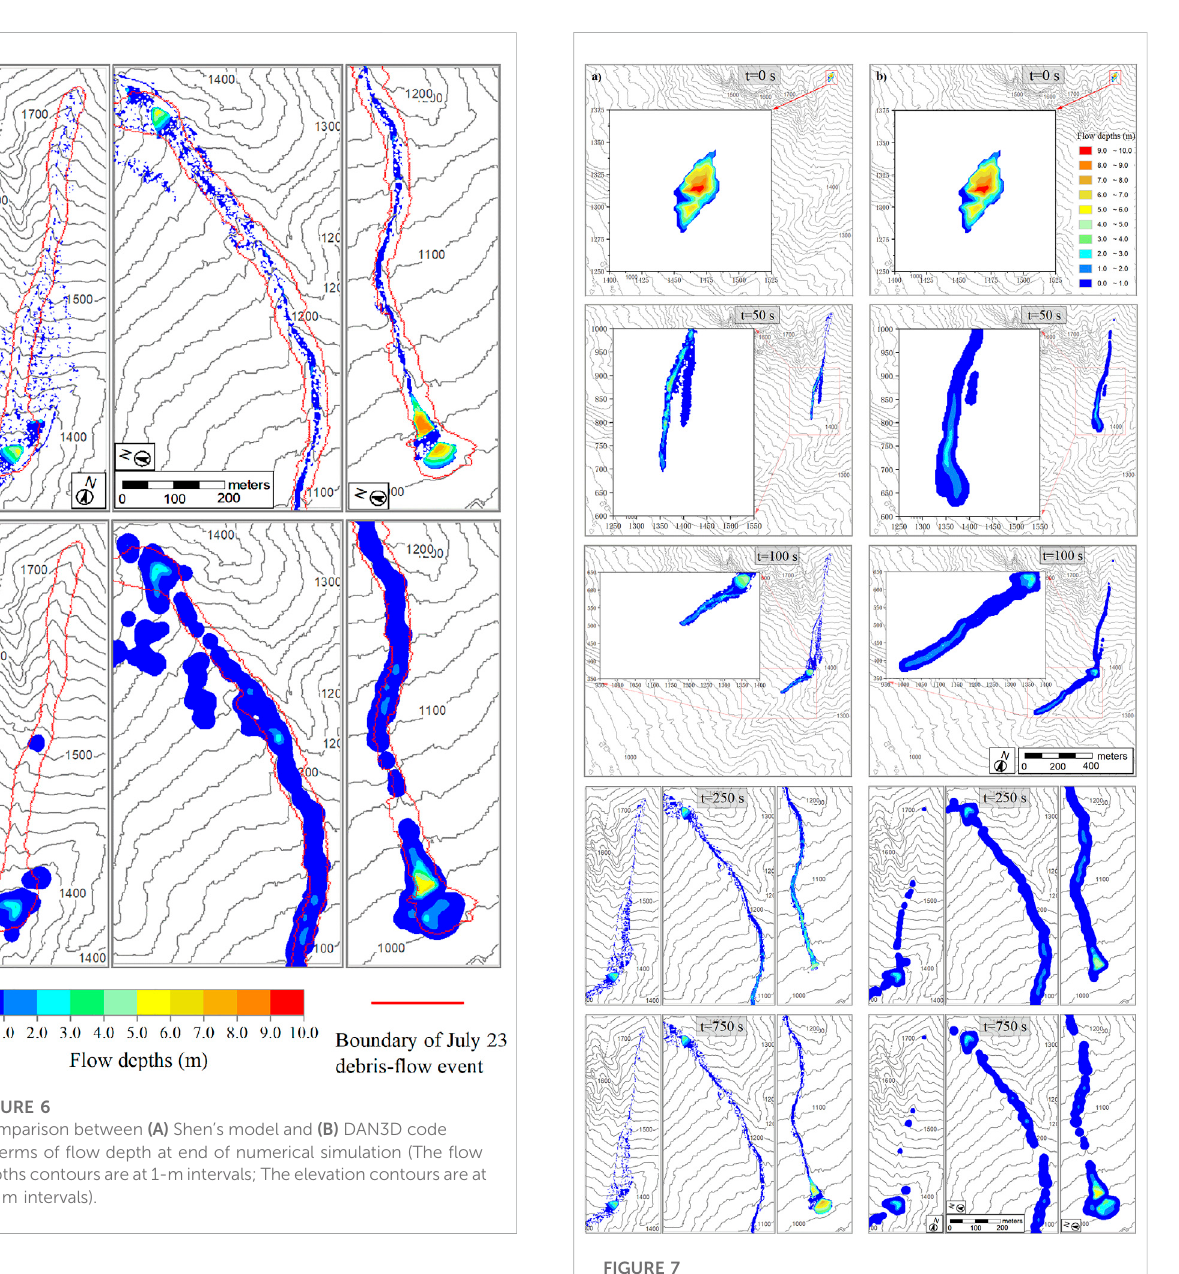
FIGURE 7 Simulated fl owdepthdistributionsof (A) Shen ’ smodeland